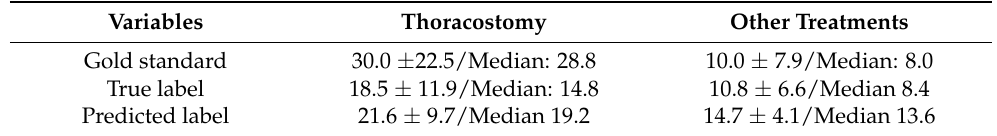
Table 5. Amount of pneumothorax between thoracostomy and other